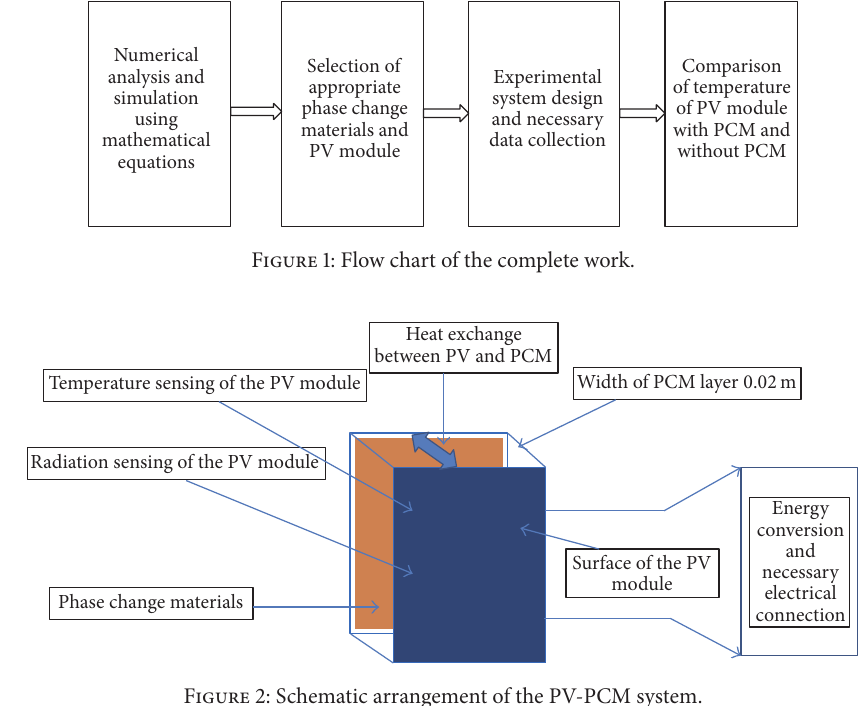
Figure 2: Schematic arrangement of the PV-PCM